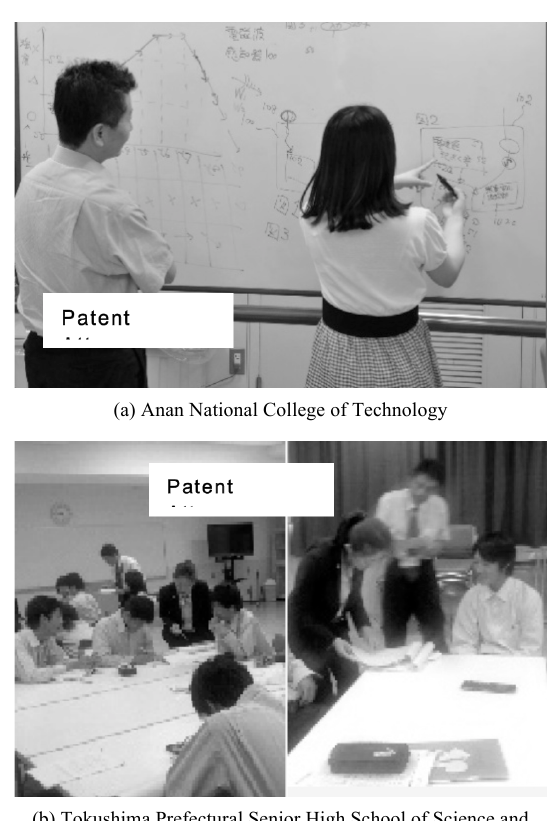
Figure 5. Pictures of seminars conducted in Anan National College of Technology and Tokushima Prefectural Senior High School of Science and Technology